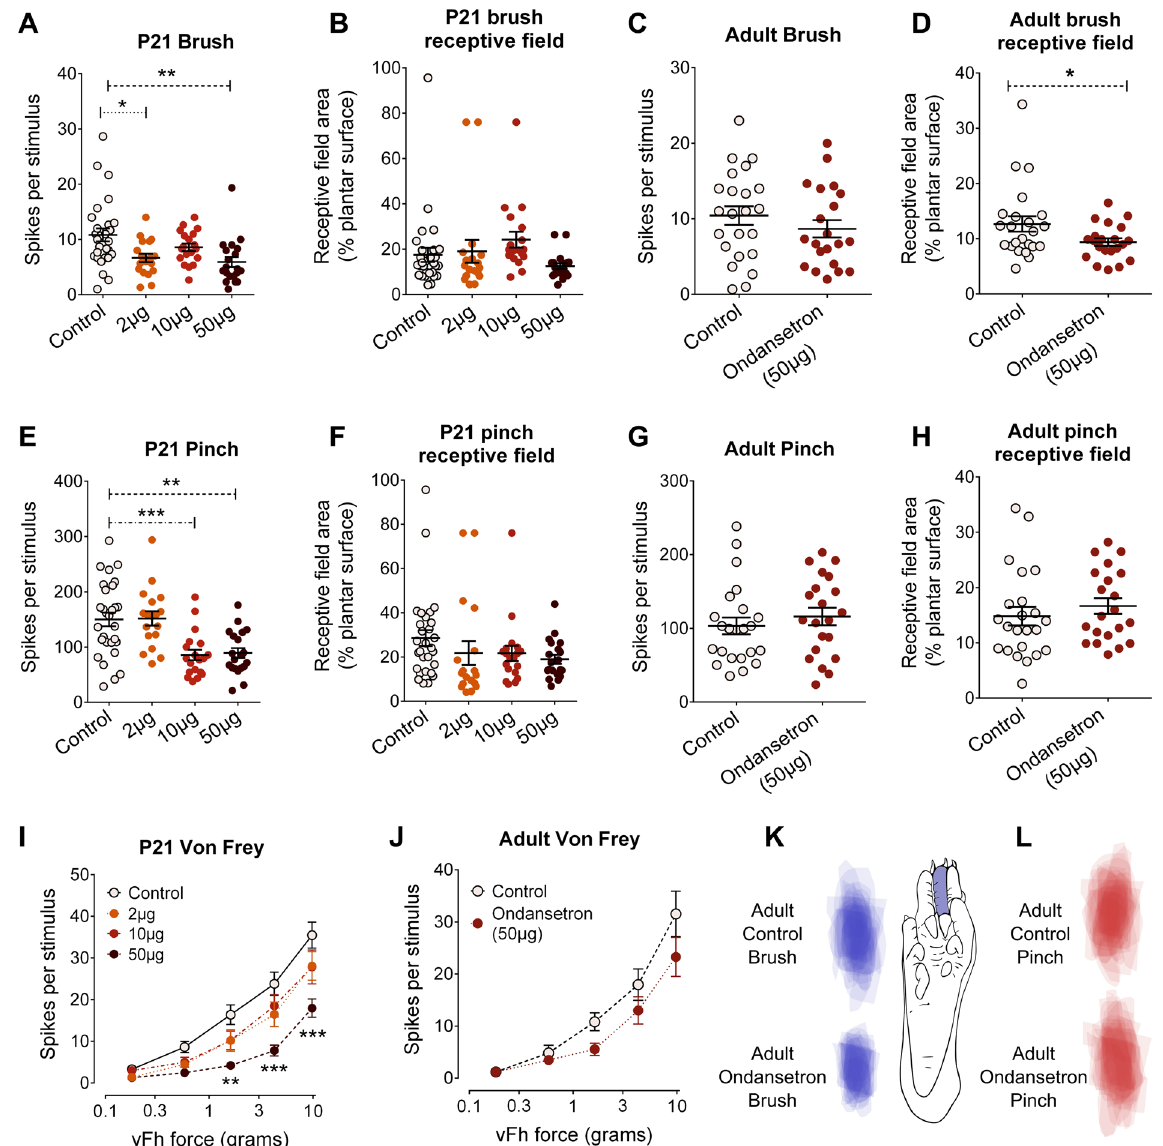
Figure 4. Ondansetron antagonism of spinal 5-HT 3 receptors has age-dependent effects on dorsal horn neuron activity. The 5-HT 3 R antagonist ondansetron was applied to the surface of the lumbar dorsal horn prior to electrophysiological recordings from WDR neurons at P21 and P40. At P21, 2 μ g and 50 μ g, but not 10 μ g, ondansetron reduced brush-evoked dorsal horn firing activity ( A ), but not receptive field areas ( B ). In adult rats, 50 μ g ondansetron reduced brush receptive field area ( D ), but not brush-evoked firing activity ( C ). Pinch-evoked firing activity was reduced in P21 rats following 10 μ g or 50 μ g ondansetron treatment ( E ). Pinch receptive field areas were not changed ( F ). In adults, 50 μ g ondansetron had no effect on pinch evoked firing activity ( G ) or receptive field areas ( H ). 50 μ g ondansetron also reduced lower and higher force von Frey hair (vFh)-evoked firing activity in P21 rats ( I ), but not in adults ( J ). Brush ( K ) and pinch ( L ) dorsal horn neuron receptive field heat maps from adult control and ondansetron rats. A typical brush receptive field from an ondansetron-treated adult dorsal horn neuron is shown in ( K ). Bars indicate mean ± SEM. * , ** , *** P < 0.05, 0.01,